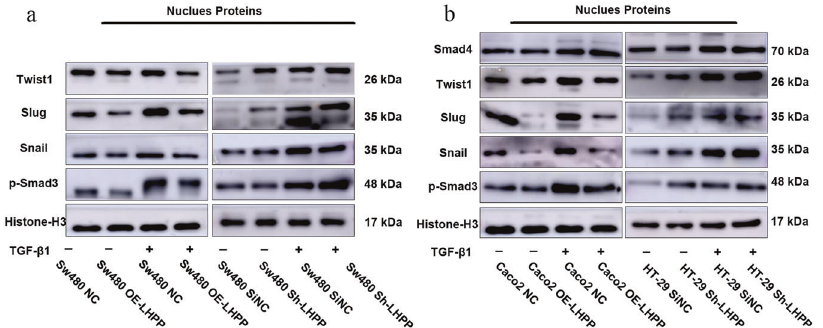
Fig. 6 We extracted nuclear proteins from different colorectal cancer cell lines after TGF- β 1 treatment for 24 h. a , b Expression levels of EMT-related transcription factors in colorectal cancer cells were examined by using western blot assay after changing LHPP expression. Histone-H3 protein was regarded as the control.